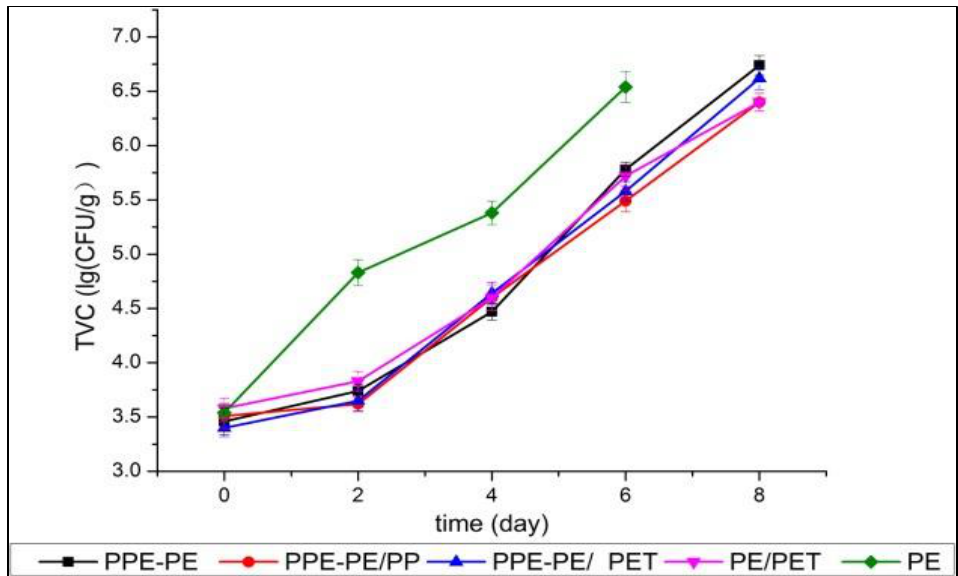
Figure 11 . Changes of total viable counts of pork during chilled storage at 4 °C. Reproduced from ref. [119] with permission from John Wiley & Sons — Journals. 2017 ref. [119] with permission from John Wiley & Sons—Journals.